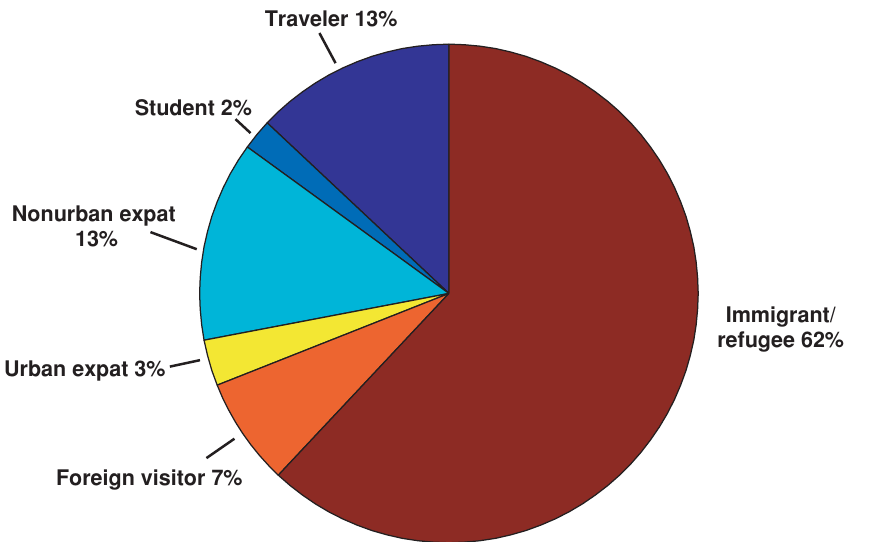
Figure 3. Reason for travel among persons with filarial infections reported in the GeoSentinel Surveillance Network.